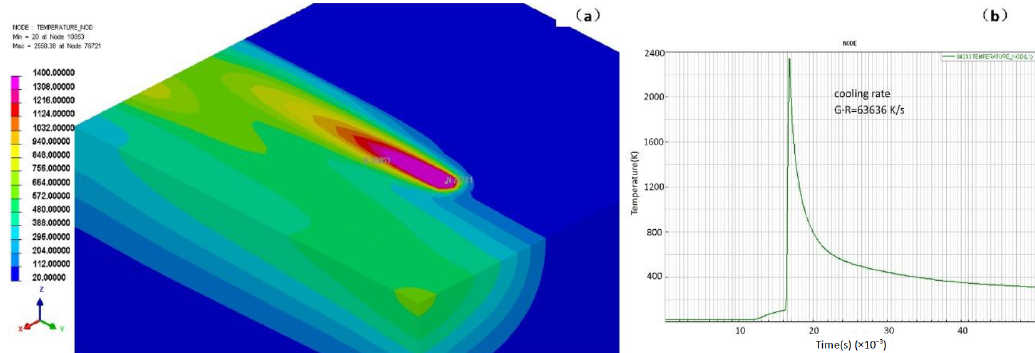
Figure 7. FEM results of 316 L by SLM; isometric view ( a ) and plot of node temperature vs. time relationship ( b ). The cooling rate (G · R, K / s) can be